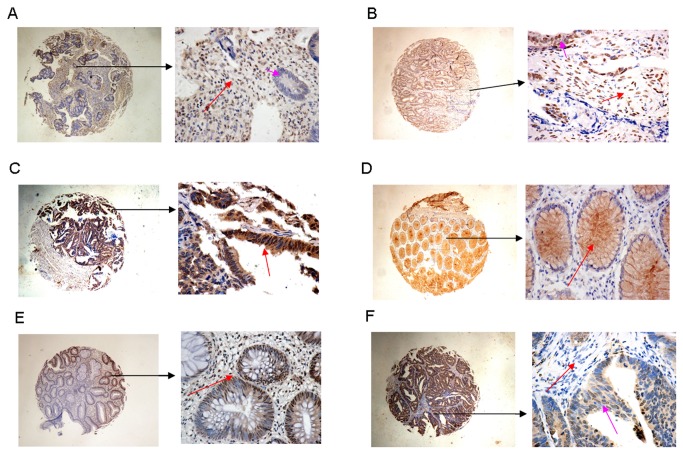
The profile of Pim-1 expression in colon cancer.(A) High level of Pim-1 expression in tumor stroma (red arrow), score 3, low level of pim-1 expression in tumor (pink arrow), score 1. (B) High level of pim-1 expression in tumor stroma (red arrow), score 3, high level of Pim-1 expression in tumor (pink arrow), score 3. (C) High level Pim-1 expression in tumor (red arrow), score 3. (D) High level of Pim-1 expression in tumor-adjacent mucosa (red arrow), score 3. (E) pim-1 in clusters within the nuclei of tumor-adjacent mucosa cells scored as fairly strong (red arrow), score 3. (F) Low level of Pim-1 expression in tumor stroma (red arrow), score 1, median level expression of pim-1 in tumor (pink arrow), score 2.